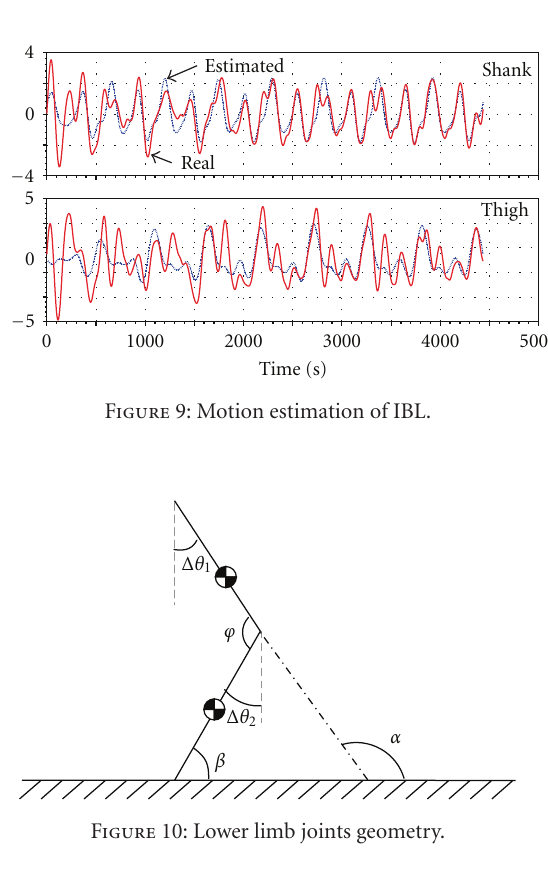
Figure 8: Desired angles of hip joint, knee joint, and ankle joint.